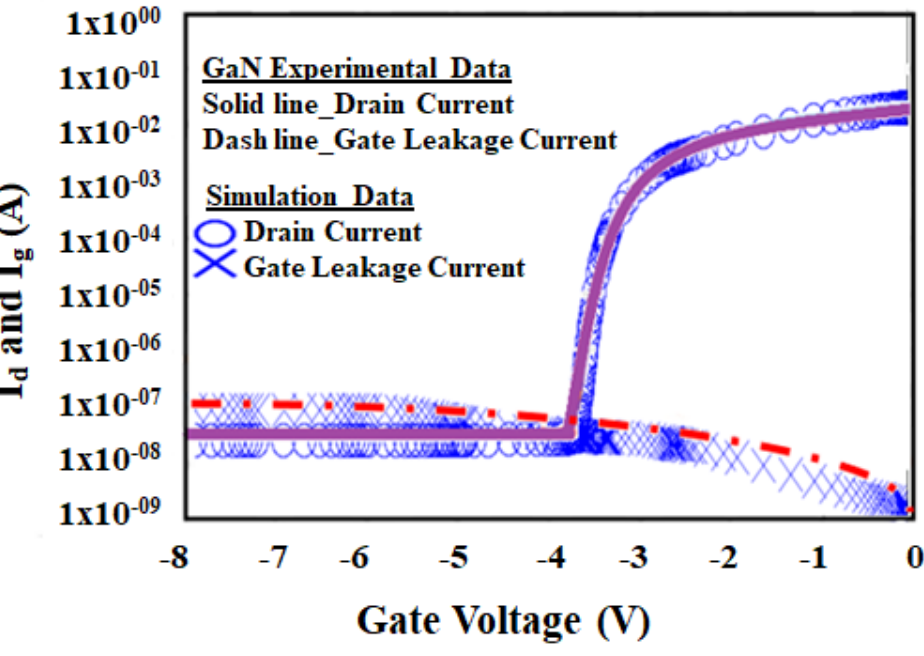
Figure 9. I d − V g characteristics comparison of simulated data and GaN wafer experimental data.